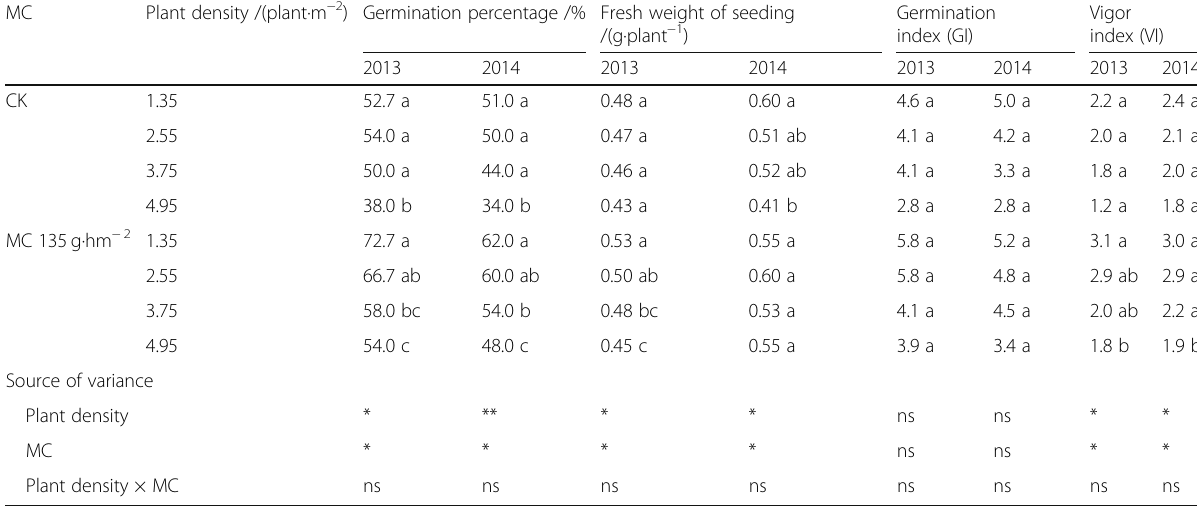
Table 4 Effects of mepiquat chloride (MC) on cottonseed vigor characters under different plant densities in Sikang 1 MC